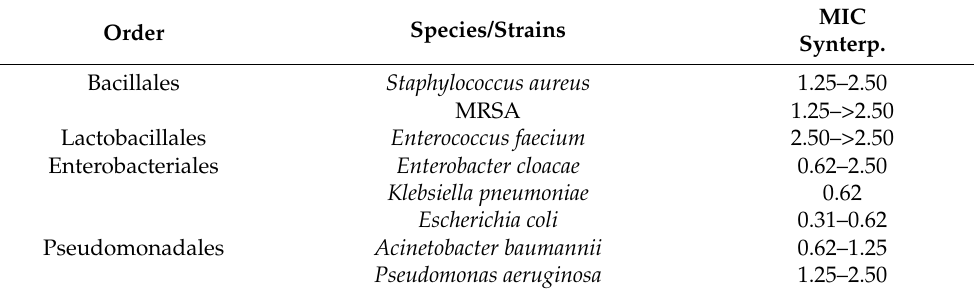
Table 4. Minimum inhibitory concentration (MIC) of Synterpicine™ on ESKAPE bacteria. MIC assays were performed on Enterococcus faecium , Staphylococcus aureus , MRSA, Klebsiella pneumoniae , Acinetobacter baumannii, Enterobacter cloacae and Escherichia coli . The range of concentrations tested is 0.00499–2.50% (v:v). Synterp.: Synterpicine™; MRSA: methicillin-resistant Staphylococcus aureus ( n = 3).